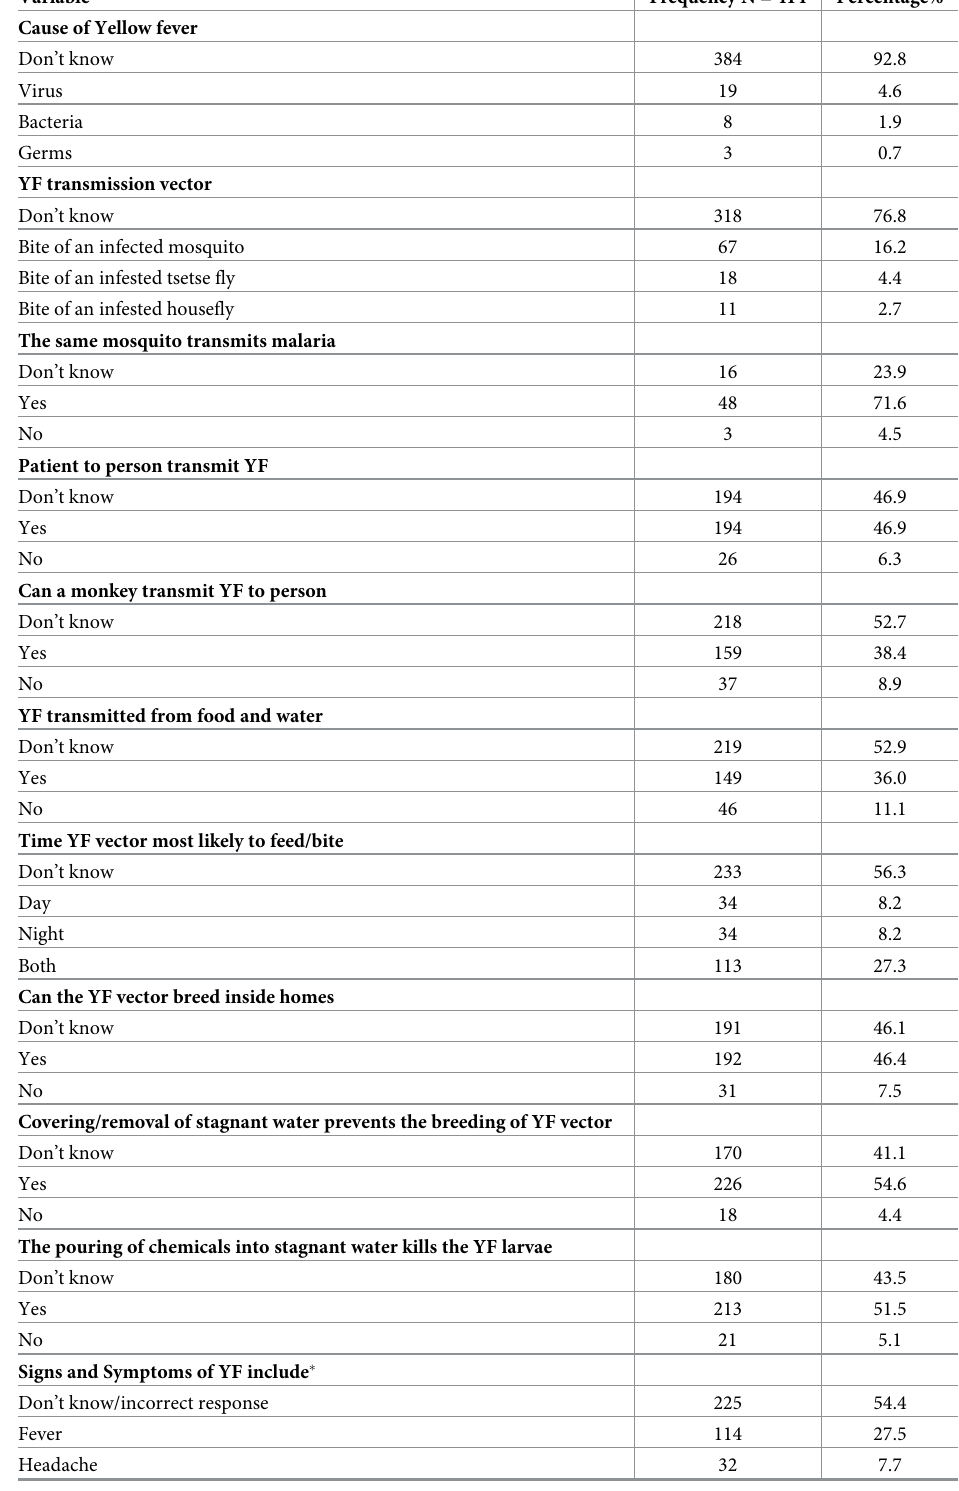
Table 2. Knowledge of yellow fever, among nomadic populations in the West Gonja Municipal Ghana,